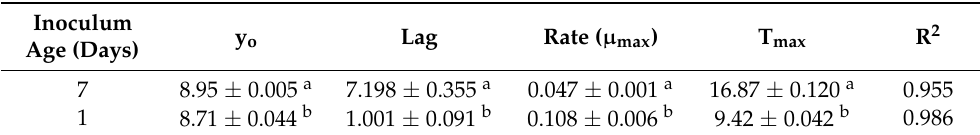
Table 1. Effect of inoculum age on the kinetic parameters of Lactobacillus acidophilus (media ± standard deviation).